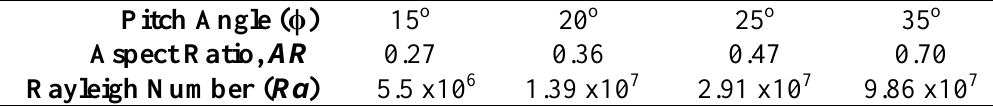
Table 1. Parametric details of the